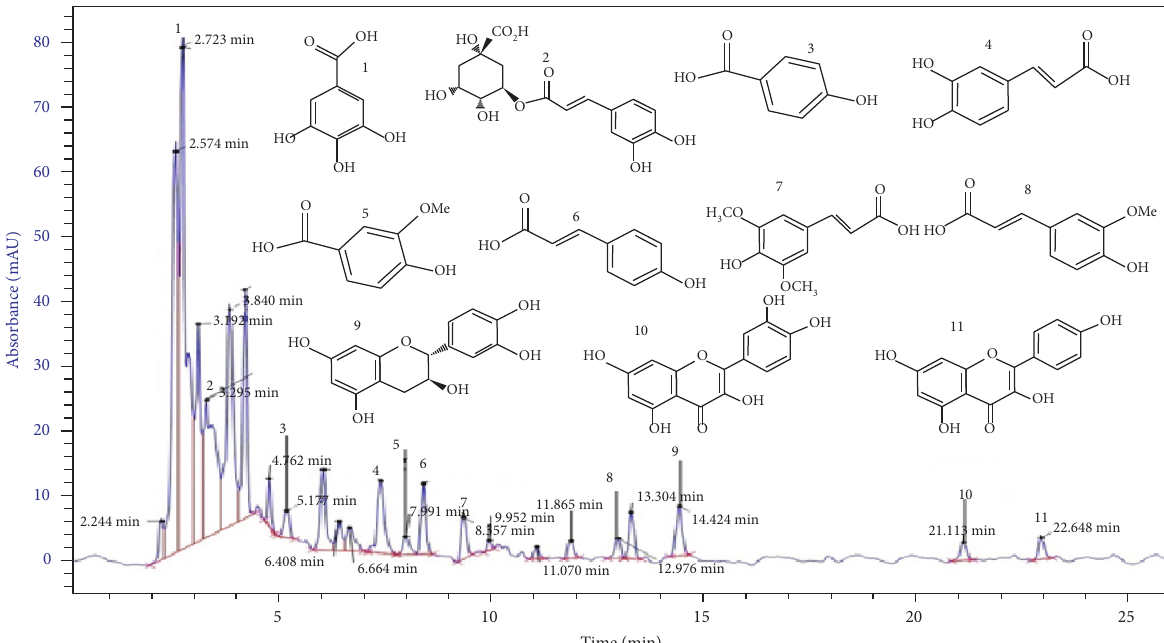
Figure 2: Typical chromatogram of phenolic acid and flavonoids of parthenocarpic tomatoes. (1) Gallic acid, (2) chlorogenic acid, (3) p- hydroxy benzoic acid, (4) caffeic acid, (5) vanillic acid, (6) p-coumaric acid, (7) sinapic acid, (8) ferulic acid, (9) catechin, (10) quercetin, and (11)